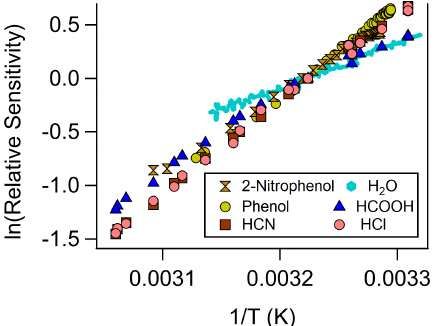
Figure 4. The van’t Hoff relationship for a selection of atmospheric trace gases using iodide-adduct ion chemistry in the NOAA CIMS (normalized at